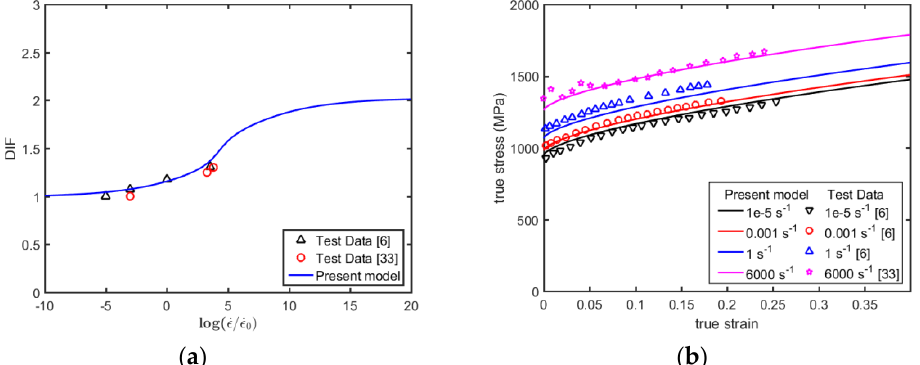
Figure 5. Comparison of the present model with the test data for 4340 steel. ( a ) DIF versus strain rate at a plastic strain of 0.05 in tension and compression at room temperature; and ( b ) true tress-true strain curves in tension.